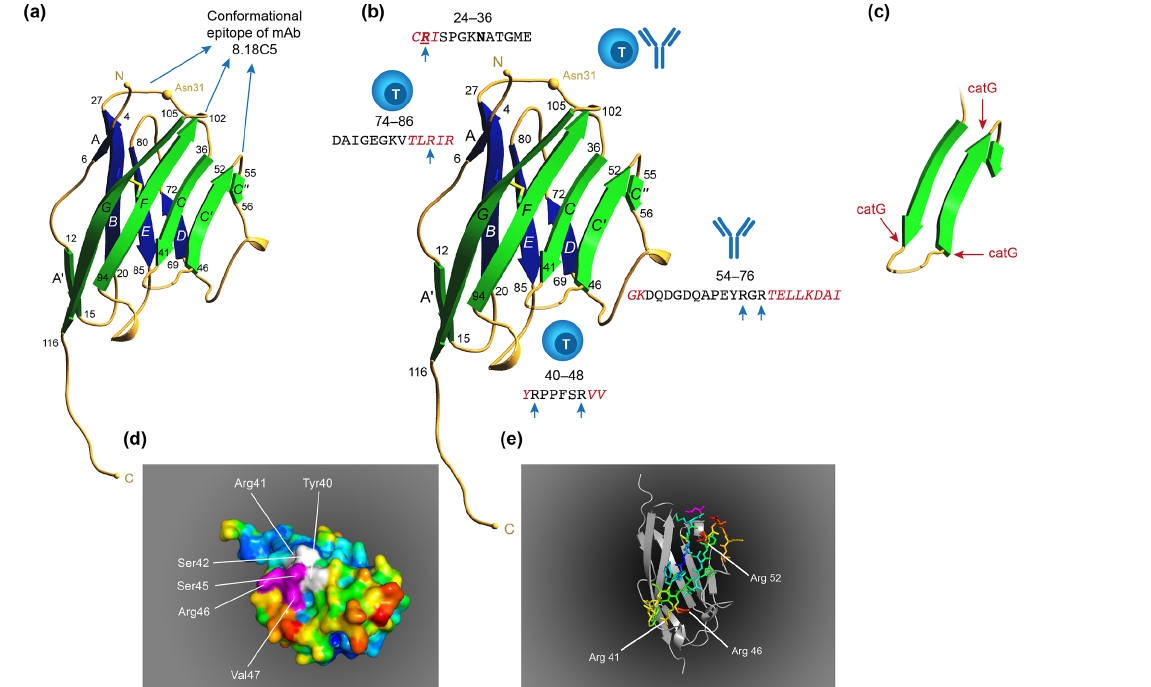
Figure 10. T and B cell epitopes plotted on the 3-D structure of MOG monomer . (a) The conformational antibody epitope is formed by the three loops that connect the B–C, C’–C” and F–G β sheets. Notice that the B–C connecting loop (residues 27–36) overlaps with the CD4 T cell epitope and contains the Asn31 residue to which in the native molecule the N-linked glycan is attached. (b) The positions of the three dominant T cell epitopes and a linear antibody epitope are indicated. Notice that these epitopes all overlap with β -sheet connecting loops. (c) An excision of the critical MOG34-56 peptide, which appears to be composed of two large antiparallel β sheets and a small one. Notice that the three critical Arg residues in the MOG34-56 peptide where the peptide can be cleaved by cathepsin G (positions 41, 46 and 52) are located at contact points of loop and β sheet. (d) Depicts a space-filling model of monomeric MOG (pdb accession number 1PKO) in molecular surface representation, colored according to B factor (blue low rms/rigid; red high rms/flexible. The surface-exposed MOG40-48 epitope (YRSPFSRVV) is indicated in white/purple. The P43 and F44 residues, which stick out of the plane towards the reader, are not resolved in the structure, probably due to the high flexibility of this part of the sequence resulting in a diffuse diffraction pattern (Breithaupt et al., 2003), the V48 residue is buried in the interior of the protein, and therefore not visible. The putative LIR motif (xSxF 43 SRV 47 ), which is part of the 40–48 epitope is shown in purple. The surface exposure of this motif enables interaction with the LC3 docking molecule of autophagosomes. (e) In a ribbon representation of monomeric MOG the three Arg residues are highlighted. It is clear from this figure that the Arg 46 and Arg 52 residues stick out while the Arg 41 residue is somewhat